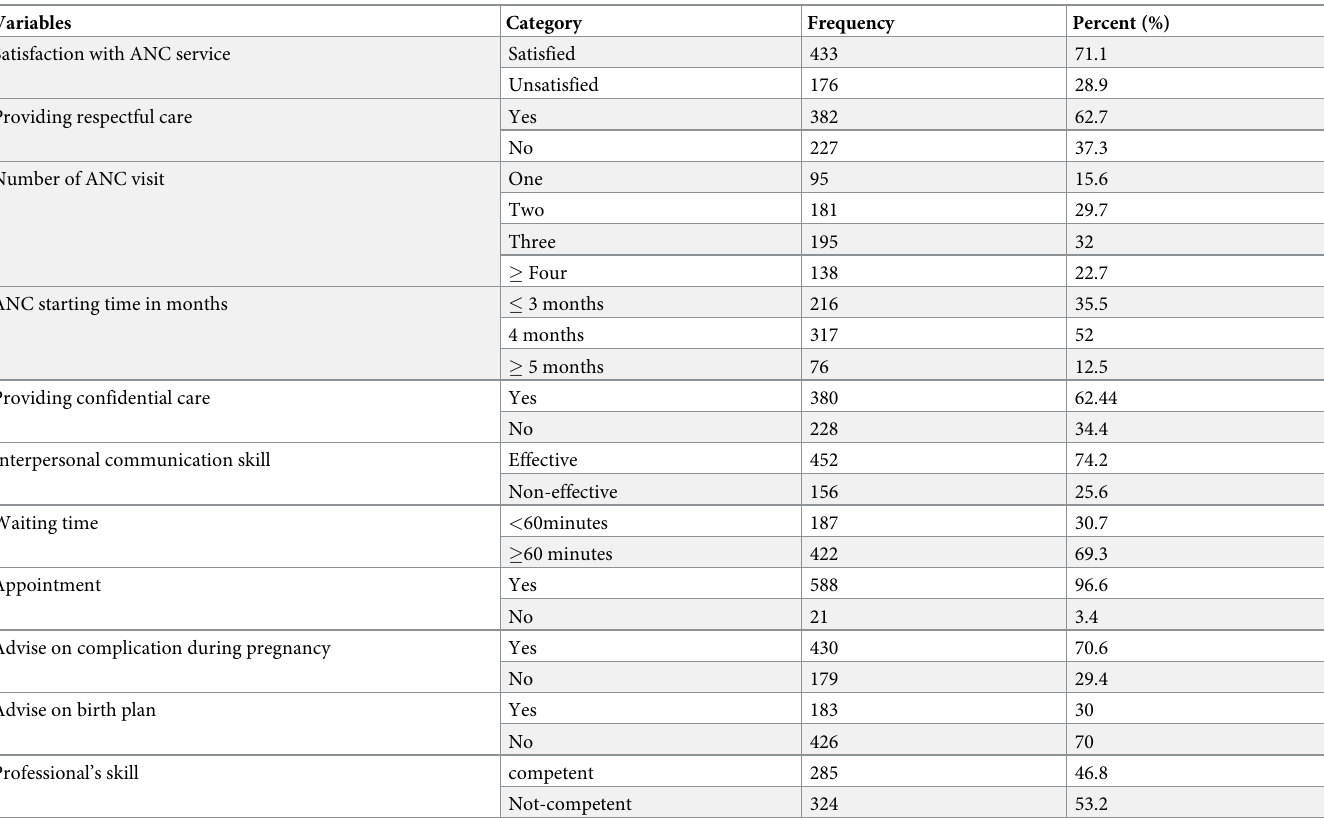
Table 2. Process and satisfaction related to ANC service provided for pregnant women attending in public health centers in Addis Ababa, February, 2020 (n = 609).